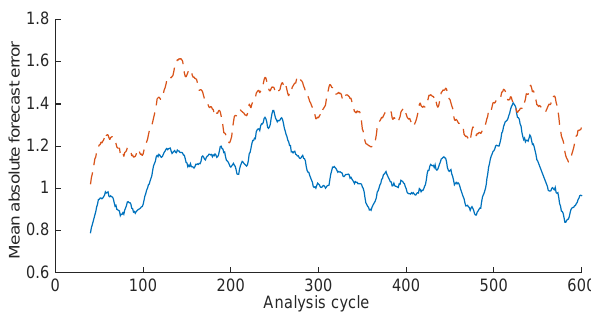
Figure 8. The 40-cycle moving average of the mean absolute fore- cast error, comparing the non-smoothed (dashed red) and smoothed (solid blue) LPF analyses. The ensemble space smoothing improves the forecast